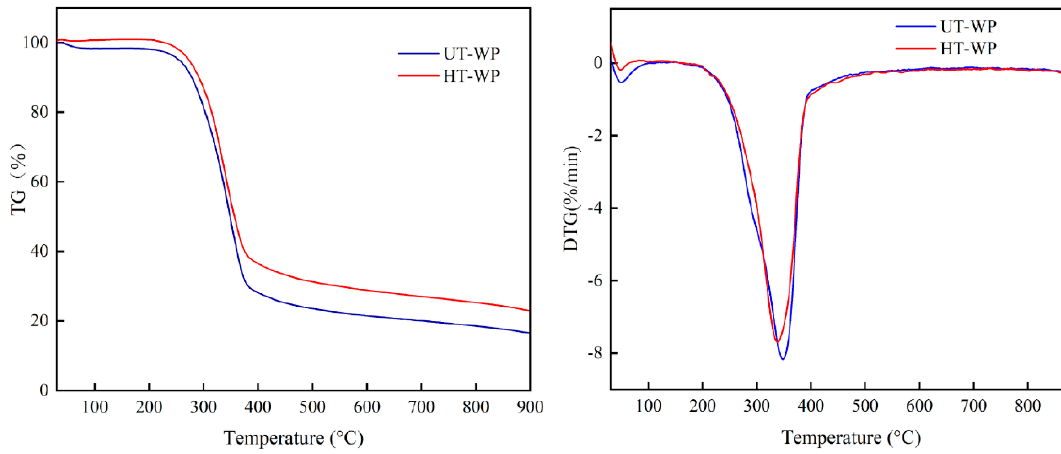
Figure 2. The pyrolysis curves of the poplar wood (UT-WP) and 220 °C heat-treated poplar wood (HT-WP). ( a ) The thermogravimetric (TG) curve. ( b )The differential thermogravimetric (DTG) curve.